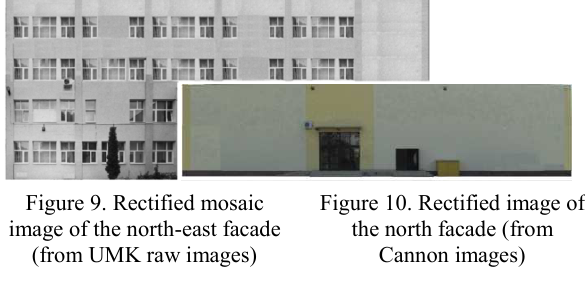
Figure 7. The 3D building Figure 8. The textured 3D model of the building (realistic